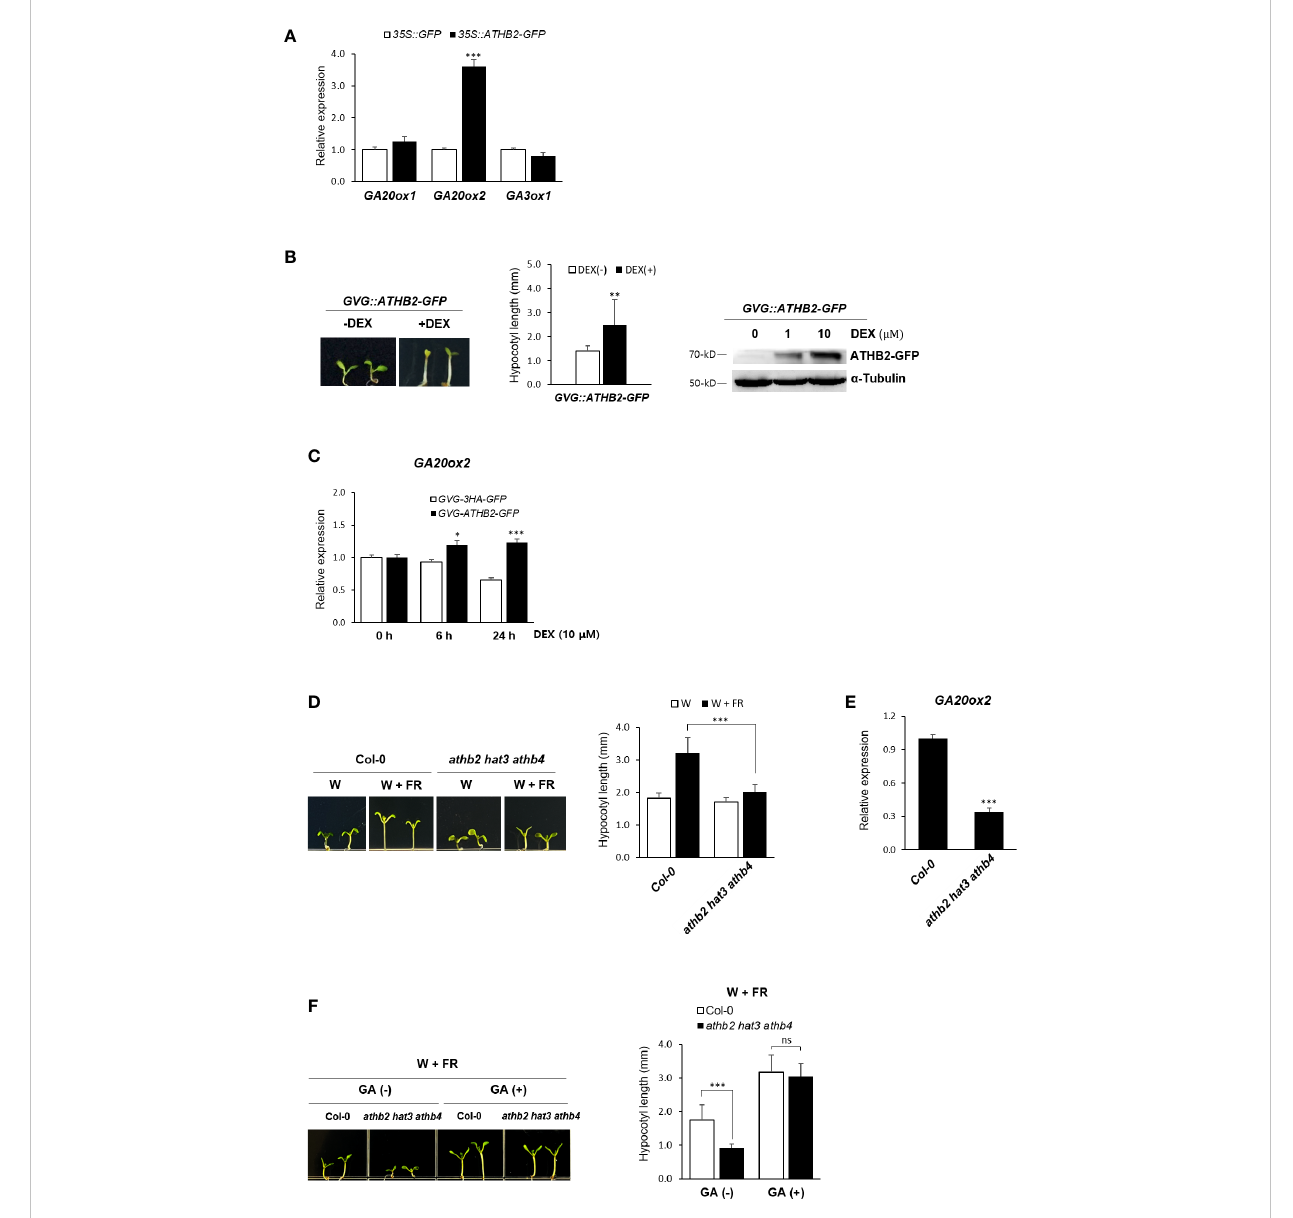
FIGURE 2 Regulation of GA20ox2 expression in ATHB2 -expressing protoplasts and transgenic plants. (A) Expression of GA20ox1 , GA20ox2 , and GA2ox3 was analyzed in Arabidopsis protoplasts transfected with plasmids containing 35S::ATHB2-GFP or 35S::GFP by real-time quantitative PCR. (B) Expression of ATHB2 in transgenic plants with GVG::ATHB2-GFP was examined after treatment with dexamethasone (DEX). Seven-day-old seedlings were grown on 1/2 MS media treated with 0.01% ethanol (-DEX) or 10 m M DEX (+DEX) (left) and their hypocotyl lengths were measured (center). Data shown are mean ± SD (n > 15). Western blot analysis using 7-day-old plants treated with DEX was performed with antisera against GFP of a tubulin (right). (C) GA20ox2 expression was examined in transgenic plants with GVG::ATHB2-GFP treated with DEX for 0 h, 6 h, and 24 h by real-time quantitative PCR. Results are representative of three independent experiments. Data shown are mean ± SD (n > 3). (D) A triple-knockout mutant of ATHB2 paralogues ( athb2 hat3 athb4 ) was grown under W or W+FR conditions and their hypocotyl lengths were measured. Data shown are mean ± SD (n > 20). (E) GA20ox2 expression was examined in 7-day-old seedlings of athb2 hat3 athb4 . Results are representative of three independent experiments. (F) A triple-knockout mutant of ATHB2 paralogues ( athb2 hat3 athb4 ) was grown under W+FR condition in the absence/presence of GA and their hypocotyl lengths were measured. Data shown are mean ± SD (n > 20). Data shown are mean ± SD (n > 3). All data were statistically evaluated using one-way ANOVA: *P < 0.05; **P < 0.01; ***P < 0.005. ns, no signi fi cant